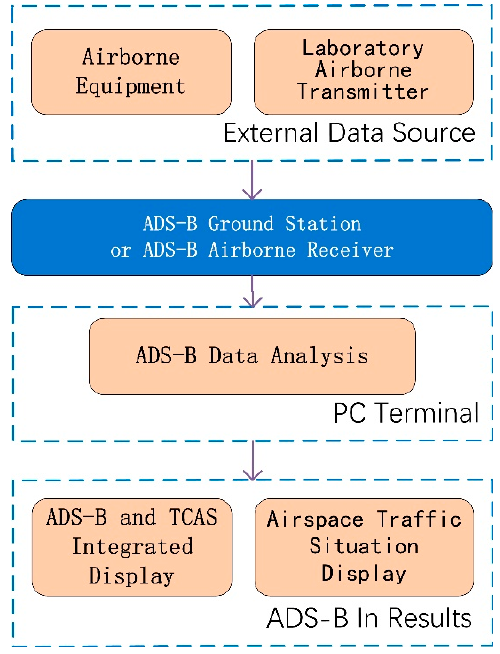
Figure 2. ADS-B In minimum system design.